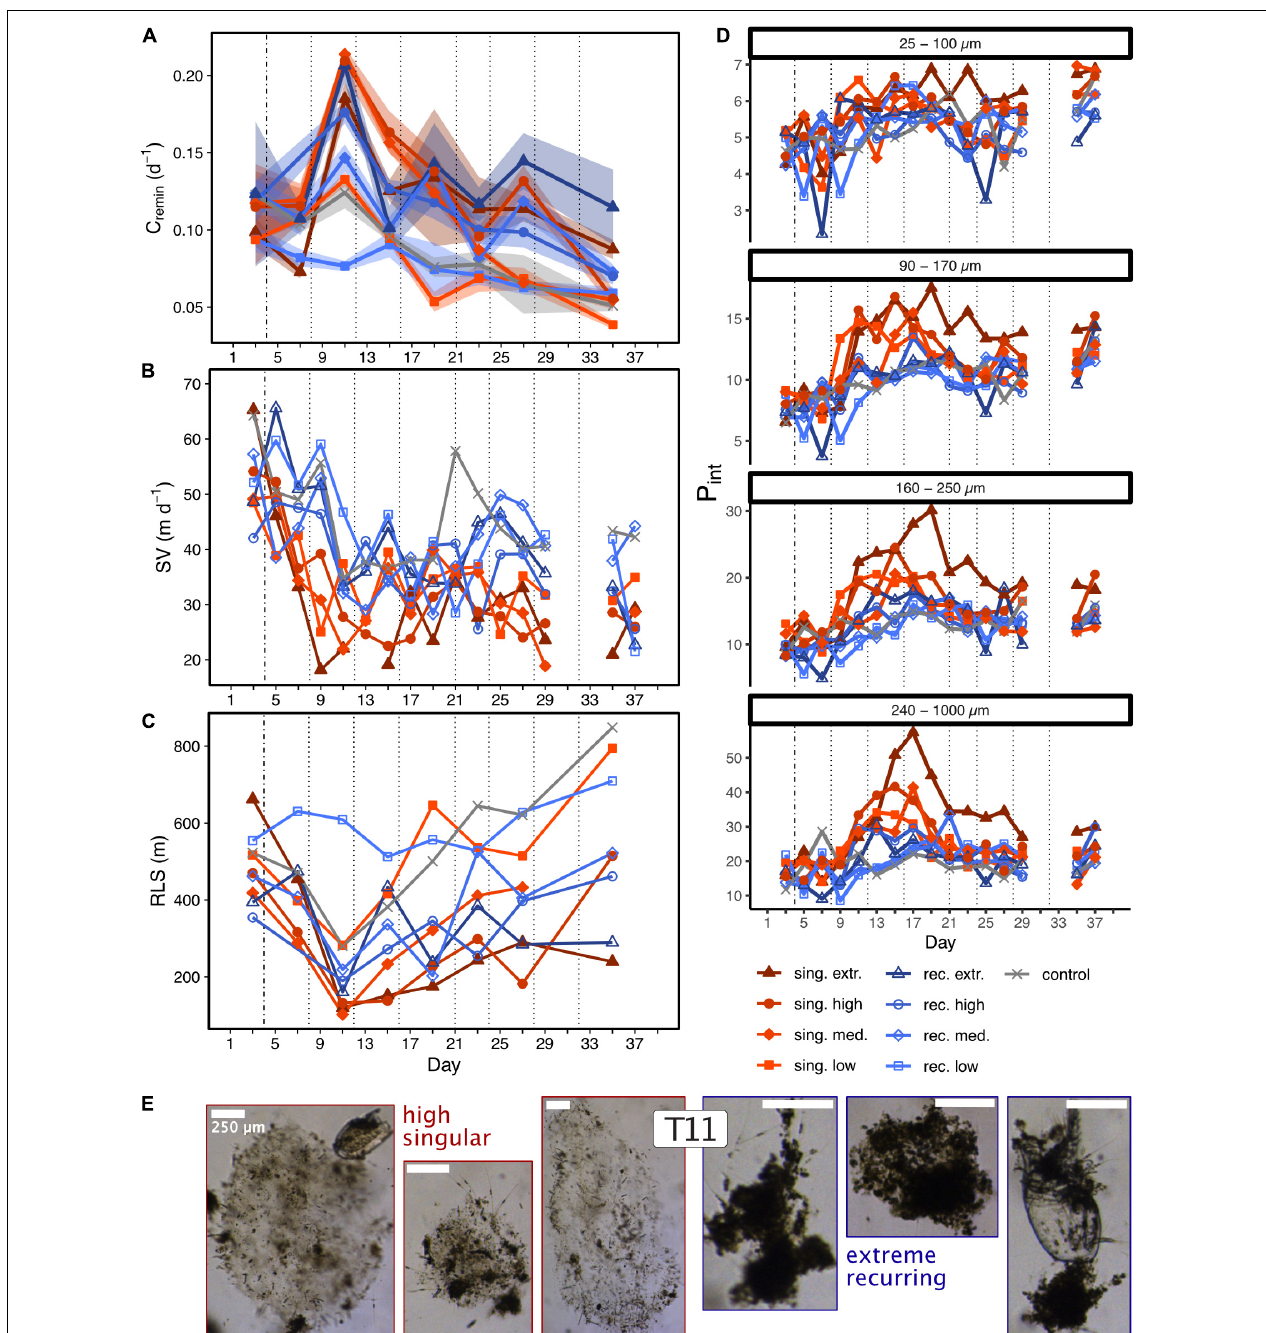
FIGURE 4 | Carbon-specific remineralization rates (A) , sinking velocities (B) , remineralization length scale (C) and particle porosities in four different size classes (D) during the 39 days of experiment. Shaded areas in (A) depict the standard deviation of measurements ( n = 4). Mind the different y -axis scales in (D) . The vertical lines are used as described in Figure 2 . (E) Shows a selection of FlowCam pictures illustrating sinking aggregates from the high singular (three pictures on the left side) and the extreme recurring treatment (three pictures on the right side) on T11. The scale bar depicts 250 µ